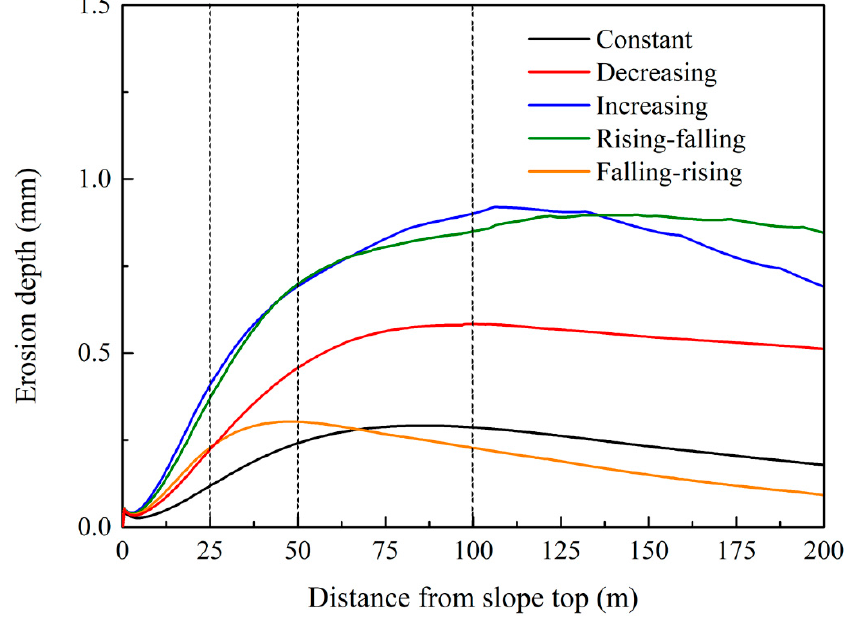
Figure 9. The erosion depth distribution along the slope axis at the 15° slope.